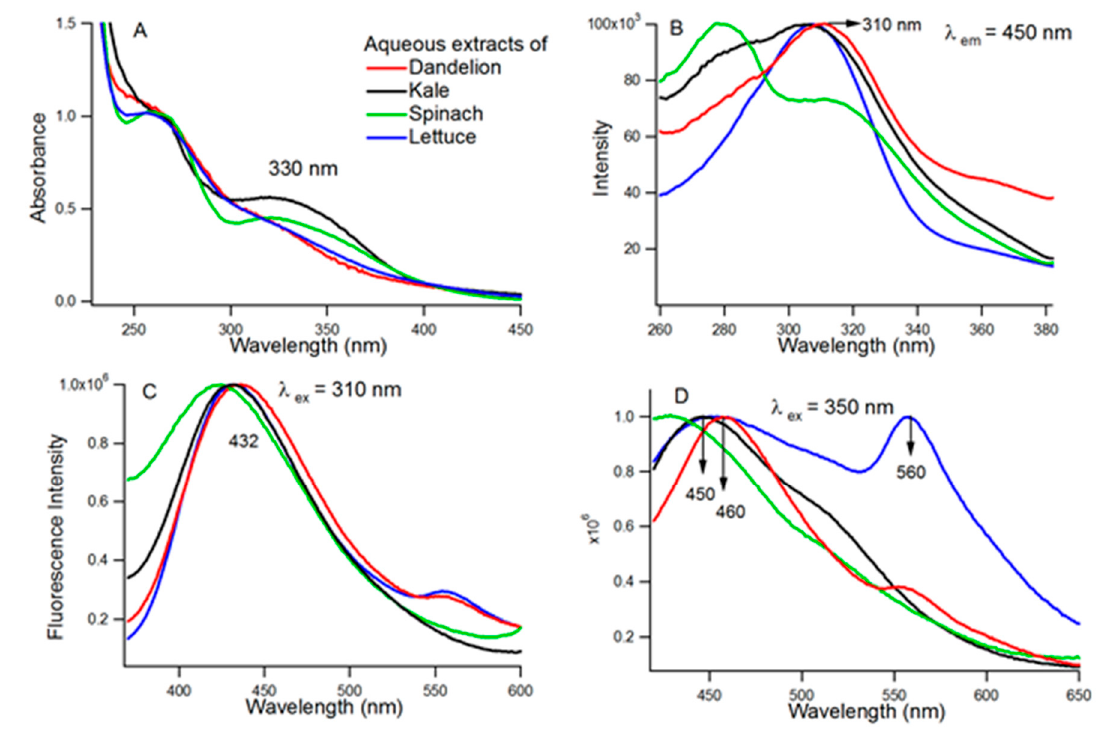
Figure 7. Normalized absorption ( A ) along with fluorescence excitation ( B ) and emission ( C , D ) spectra of the vegetable juices, λ em = 450 nm ( B ), λ ex = 310 nm ( C ), λ em = 350 nm ( D ). The excitation and emission slit widths were 3/3 nm.